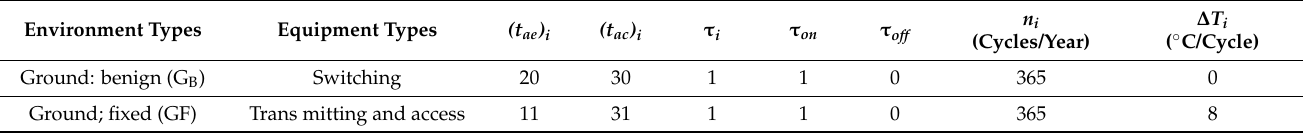
Table A2. Mission profile for a permanent working